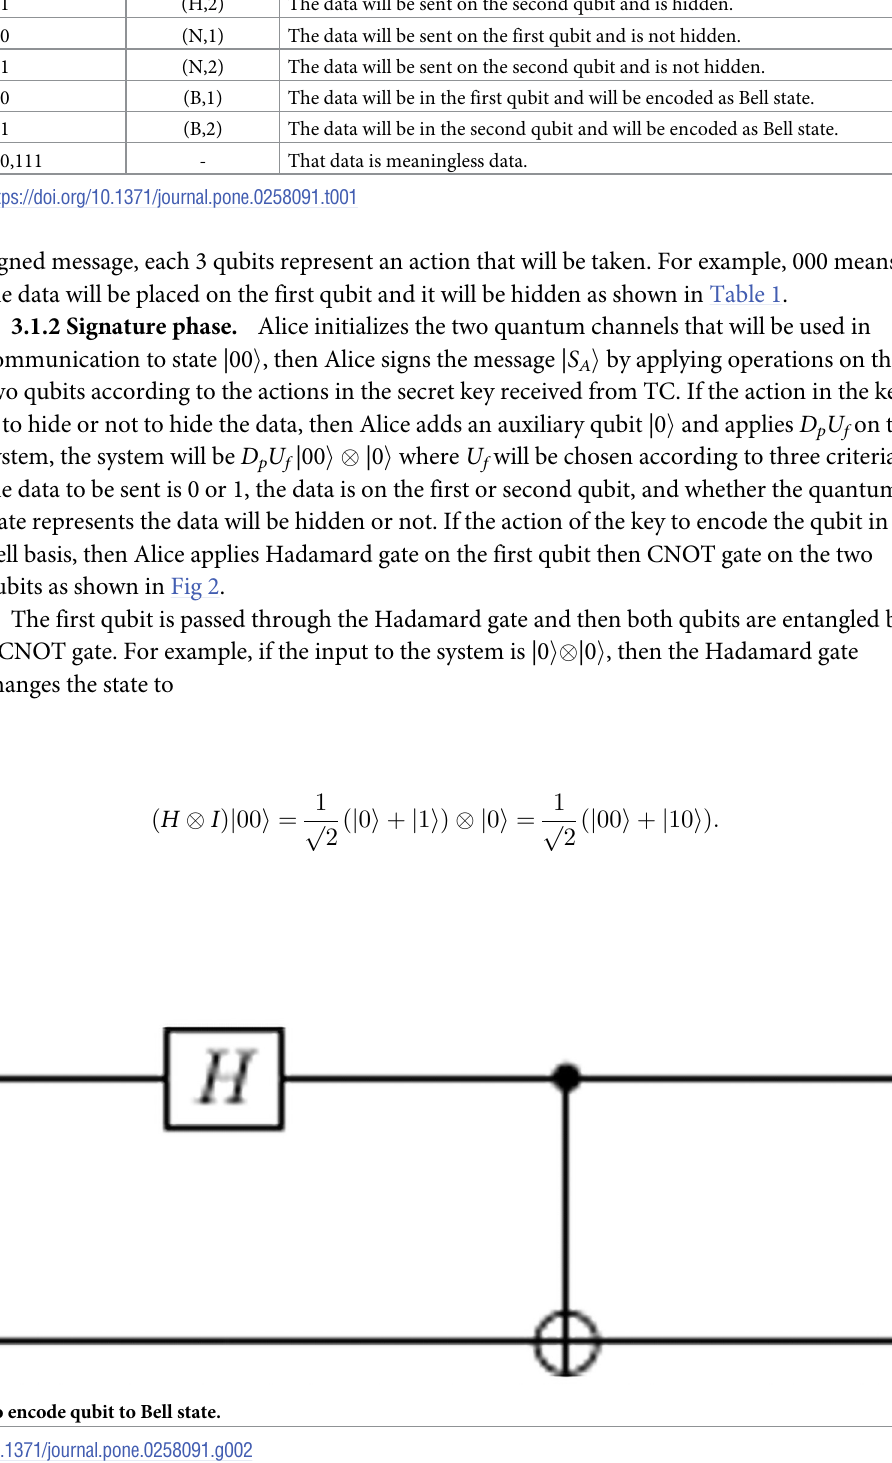
Table 1. Actions that can be taken and shared on a secret key. Qubit Symbol Meaning 000 (H,1) The data will be sent on the first qubit and is hidden. 001 (H,2) The data will be sent on the second qubit and is hidden. 010 (N,1) The data will be sent on the first qubit and is not hidden. 011 (N,2) The data will be sent on the second qubit and is not hidden. 100 (B,1) The data will be in the first qubit and will be encoded as Bell state. (B,2) The data will be in the second qubit and will be encoded as Bell state.